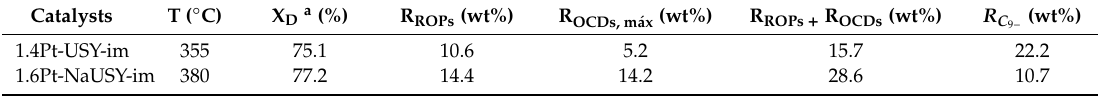
Figure 5. Modified hydrocracking selectivity (%) obtained at a constant cracking yield (C 9 − ~ 20 wt%) for 1.4Pt-USY-im and 1.6Pt-NaUSY-im catalysts. Reaction conditions: P = 35bar, H 2 / D = 100, and WHSV = 3.22 h − 1 . Table 4. Maximum yields of OCDs obtained for 1.4Pt-USY-im and 1.6Pt-NaUSY-im catalysts.